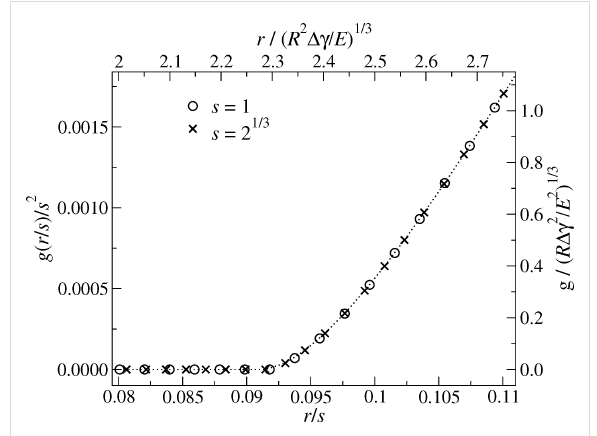
Figure 3: Scaled gap g ( r ) as a function of scaled distance from origin r for two different parameter realizations related through the scaling transformation Equation 13–Equation 17. Parameters used are E = L = μ T = 1, F N = 1·10 − 4 / w and Δγ = 0.64·10 − 4 / w . The surface is discretized into 512 × 512 elements. Circles s = 1 with w = 1 → z 0 = 0.0016, crosses w = 1/2 → z 0 = 2 2/3 · 0.0016. For the second data set, this implies a scaling factor of t = 2 2/3 for variables linear in normal coordinates and thus s = 2 1/3 for variables proportional to in-plane coordinates. The units on the normal side of the axes are in “absolute” units, i.e., L = 1. The units on the opposite axes correspond to those that remain invariant under a scaling transformation. The dotted line is drawn to guide the